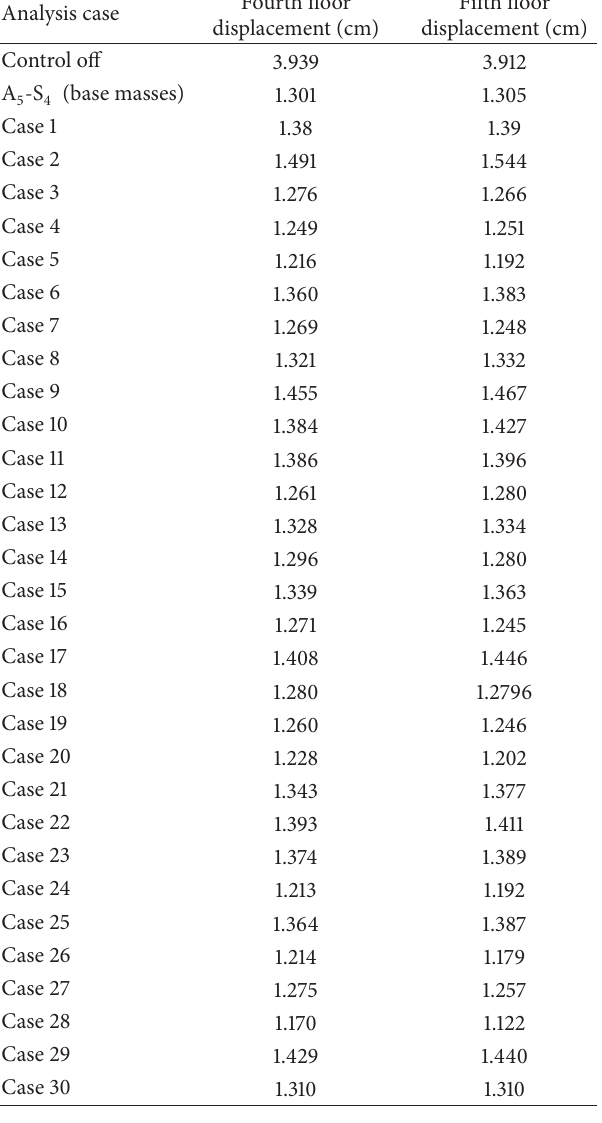
Table 11: The effect of uncertainty on fourth and fifth floor displacement.